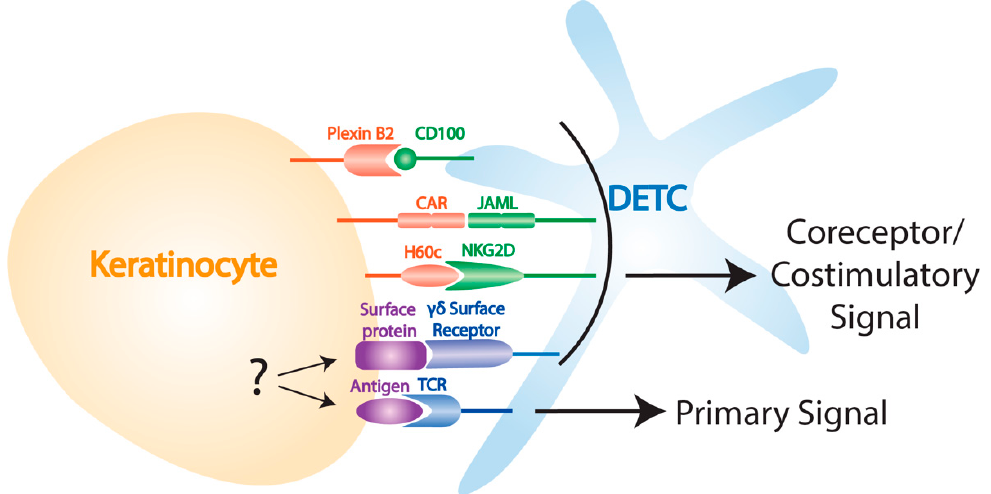
Figure 1. Ligands involved in DETC activation. Keratinocyte-DETC interactions are important for DETC activation post-wounding. Known interactions include CD100-plexin B2, JAML-CAR, NKG2D-H60c, and primary signaling through TCR following interactions with an unknown antigen.